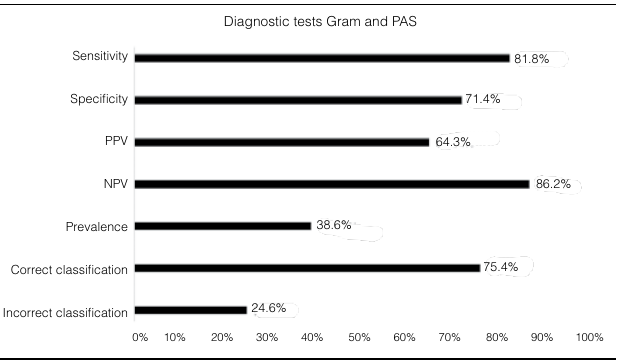
figurE 2 – Statistical analysis of Gram’s method in relation to PAS PAS: periodic acid-Schiff; PPV: positive predictive value; NPV: negative predictive